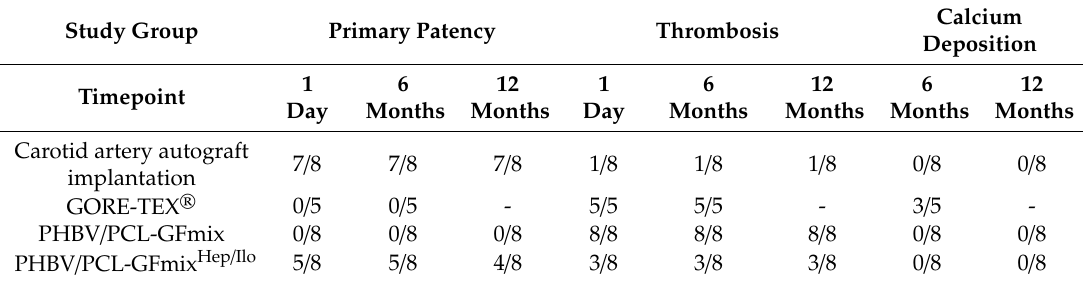
Figure 5. Representative images of PHBV/PCL-GFmix Hep/Ilo grafts explanted 6 months following surgery. ( a ) Magnification ×50. ( b ) Magnification ×200. Scale bar = 100 μ m.